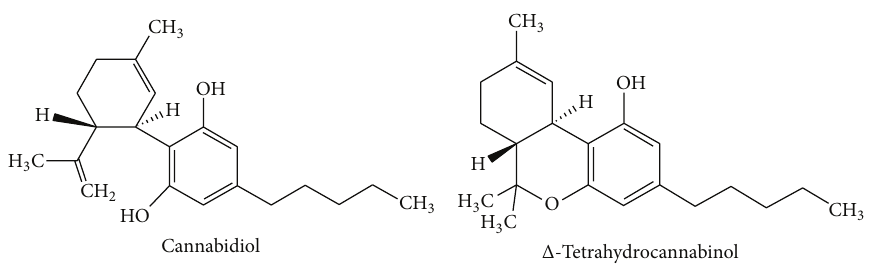
Figure 6: Chemical structures of Cannabis sativa compounds.